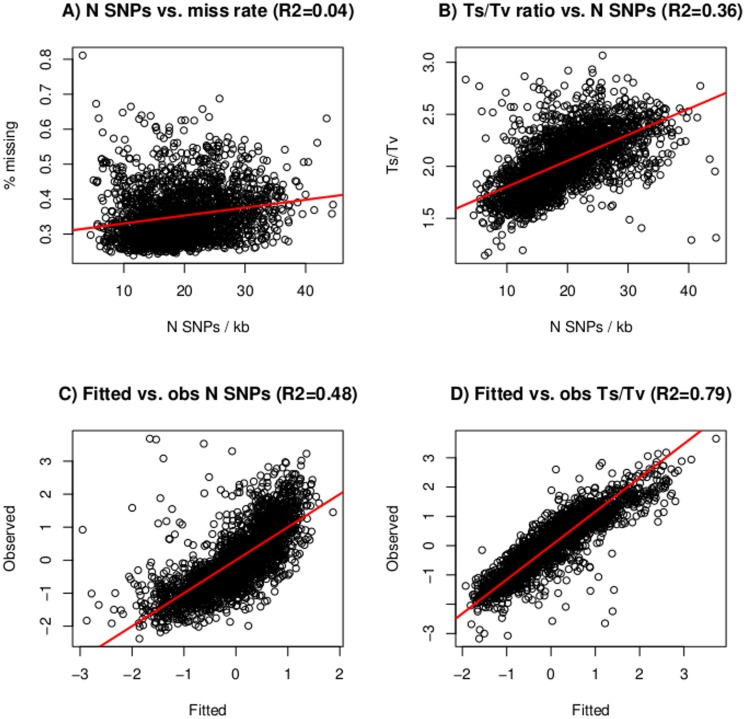
Number of SNPs vs. missing rate (a), and vs. Ts/Tv ratio (b); fitted vs. observed number of SNPs (c) and Ts/Tv (d) using equations 1 and 2, respectively.